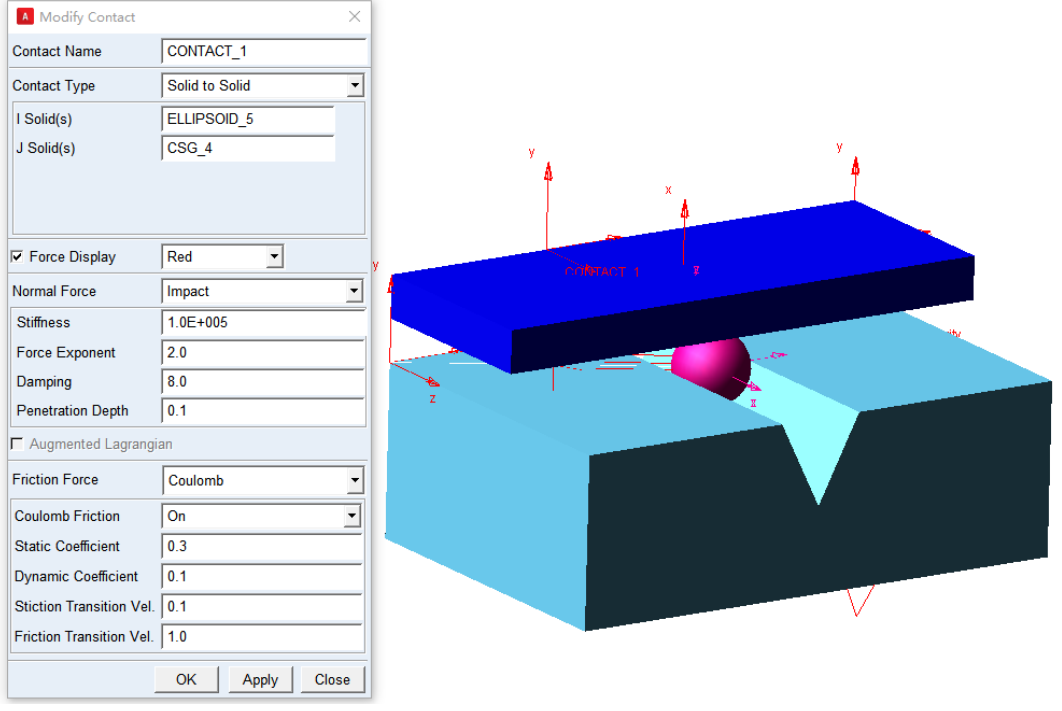
Figure 7. Modelling of CMRF process in ADAMS.